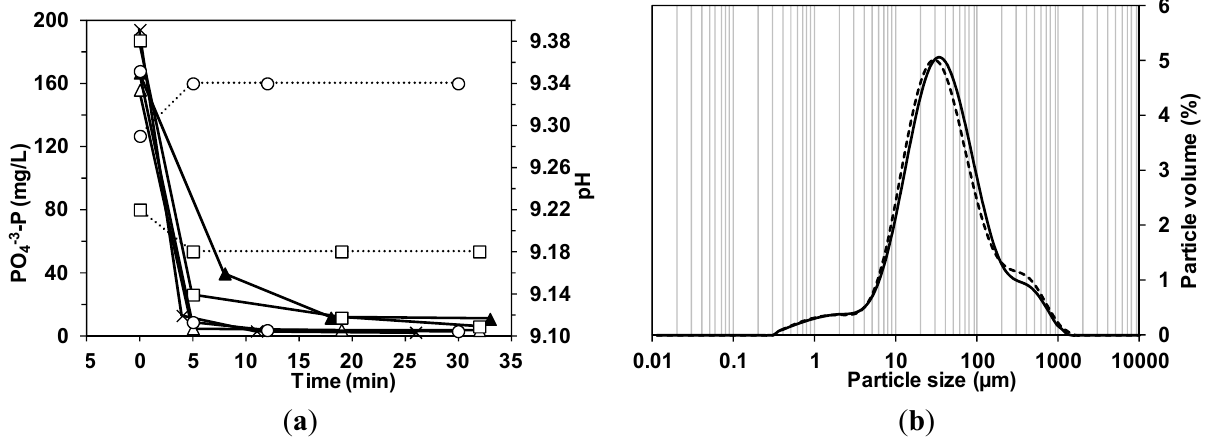
Figure 2. ( a ) Evolution of phosphorus concentration ( ─ ) and pH (···) values in the reactor in the experiments: Tank 1 (  ), Tank 2 (  ), Tank 3 (  ), Tank 4 (  ) and Tank 5 (  ); ( b ) Crystal size distribution of particles in Tank1, before the addition of magnesium ( ─ ) and at the end of the experiment